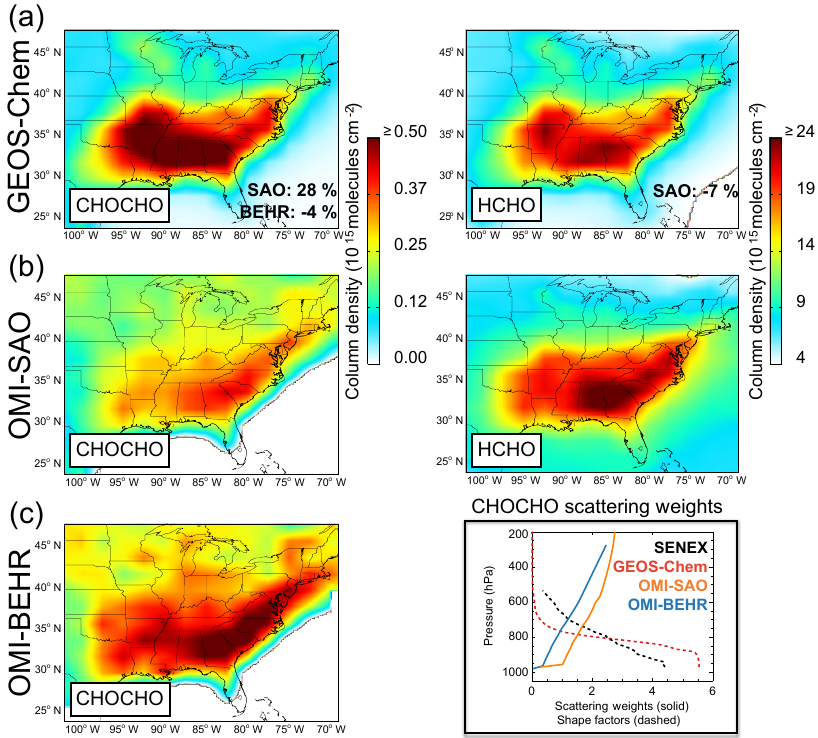
Figure 7. Mean CHOCHO and HCHO columns in summer (JJA) 2006–2007. GEOS-Chem model values (a) are compared to OMI satellite observations (b, c) . OMI-SAO is the standard operational product (Chan Miller et al., 2014; González Abad et al., 2015). The OMI-BEHR product for CHOCHO uses tropospheric scattering weights from the BEHR NO 2 retrieval (Russell et al., 2011; Laughner et al., 2016). The OMI HCHO observations have been scaled up by a factor of 1.67 to correct for retrieval bias (Zhu et al., 2016). The normalized mean bias (NMB) between GEOS-Chem and OMI in the southeast US (75–100 ◦ W, 29.5–37.5 ◦ N) is shown within the GEOS-Chem panels. The right panel of (c) shows the mean CHOCHO scattering weights ( w ) from the OMI-SAO and OMI-BEHR retrievals and the vertical shape factors ( s ) over the southeast US from the SENEX observations and GEOS-Chem in the southeast US from a typical orbit (10114, 9 June 2006).